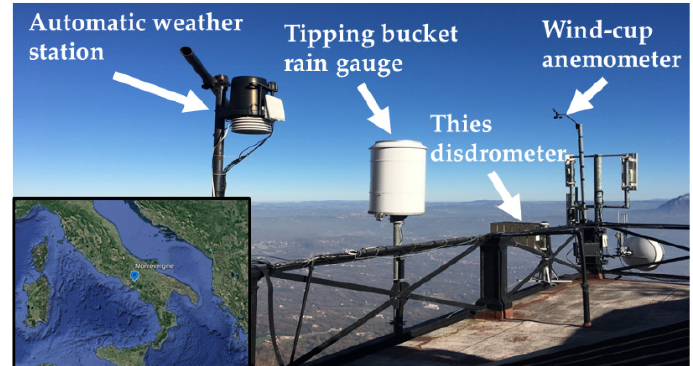
Figure 1. The measurement devices placed on Montevergine Observatory terrace: automatic weather station (temperature and humidity), FAK010AA reference rain gauge, Thies disdrometer and wind-cup anemometer (which is part of the AWS). Inside panel shows a map of Italy and the location of Montevergine Observatory (LAT = 40.936502°N, LON = 14.72915°E, 1280 m asl).